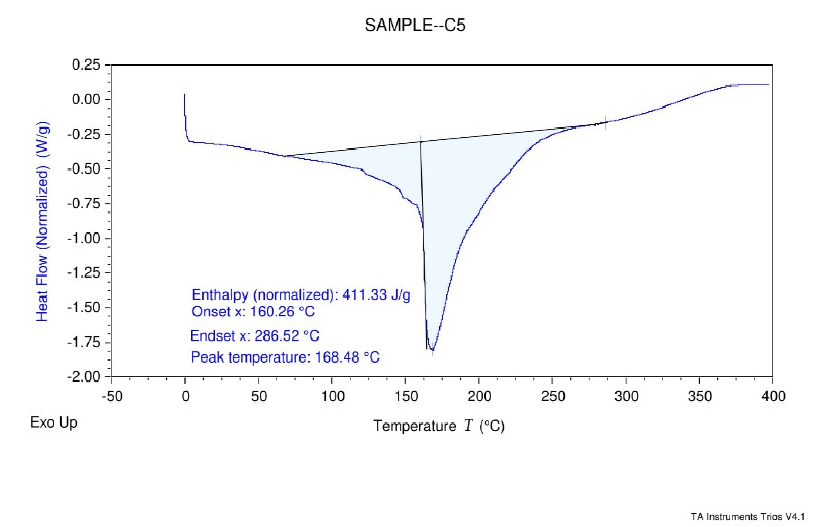
Fig. 8. Differential Scanning Calorimetry of nanocellulose